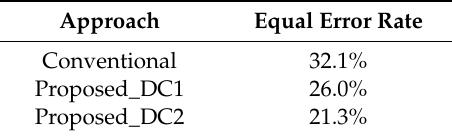
Table 1. EER (%) of trigger word detection.